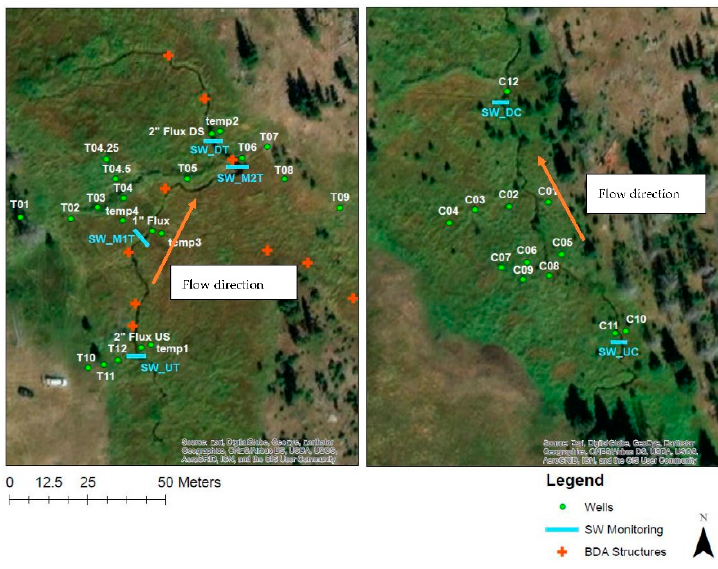
Figure 3. Groundwater and surface water monitoring locations. ( Left ) Treatment reach. ( Right )